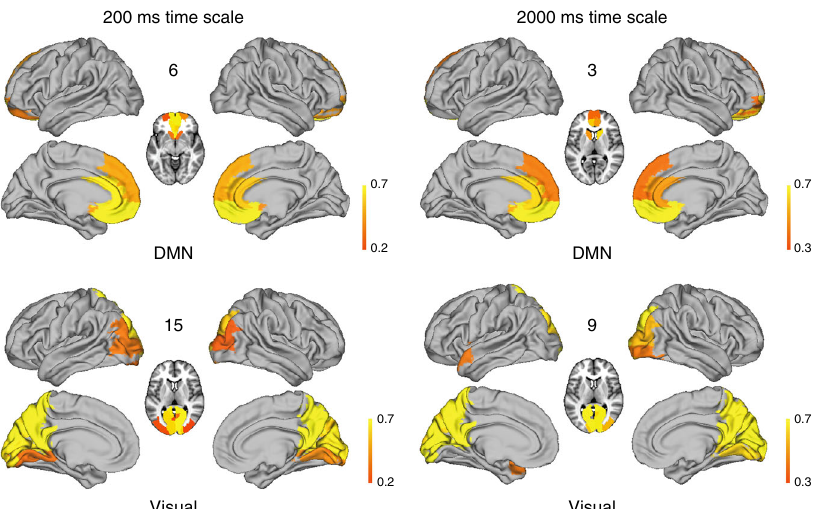
Fig. 5 Comparison of resting state networks at optimal (left, 200 ms) and slow BOLD (right, 2000ms) timescales. The fi gure shows the similarity of the spatial characteristics of the spacetime motifs networks found at both timescales. As an example, the visual network (bottom) and frontal part of the default mode network (top) are shown. Thus, classical methodologies used for extracting resting state networks are valid for fi nding the spatial components but of course less suitable for extracting the underlying temporal dynamics given the inherent temporal constraints of BOLD